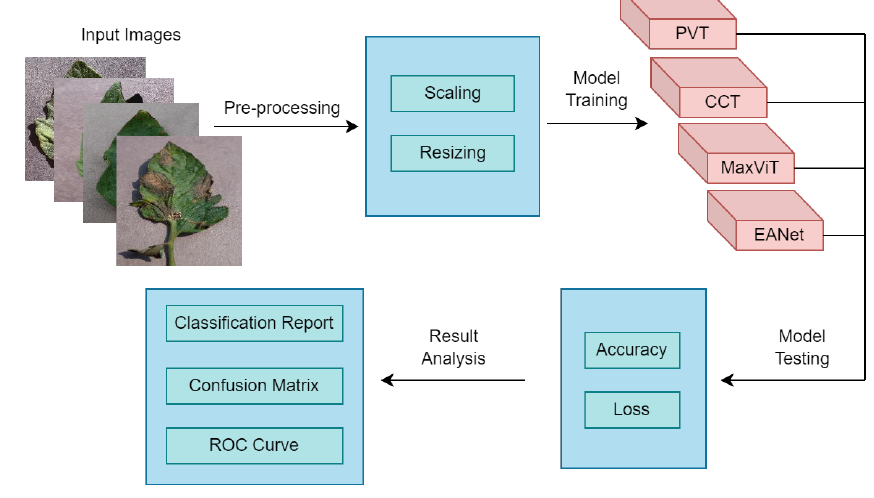
Figure 8. Summary of the